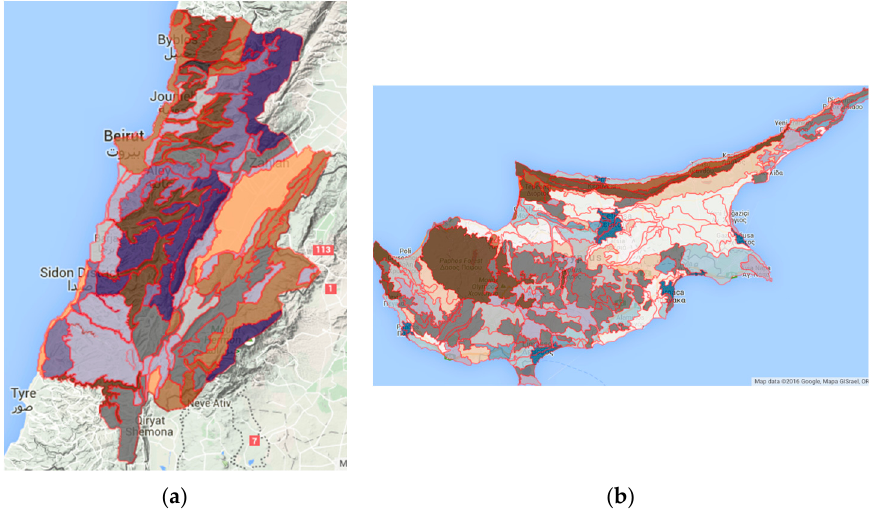
Figure 17. Landscape Risk Assessment (LRA) maps for Lebanon ( a ) and Cyprus ( b ).